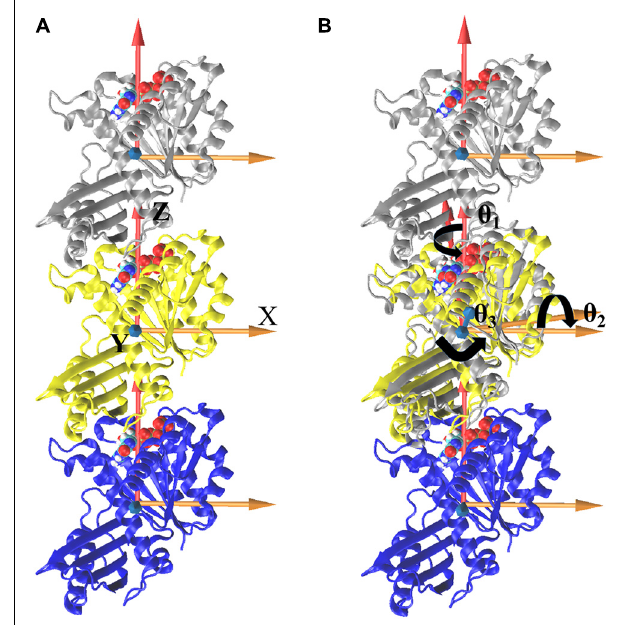
FIGURE 4 | Definitions of bending and twisting angles. Overall, the coordinate system was defined by aligning the z axis along the center of mass position of the one subunit to that of another subunit, fixing the x axis along a preferred bending direction for the trimer and defining an orthogonal y axis (A) . To measure the relative motions, trimer was first aligned with respect to the initial straight frame by superposing the middle subunits (yellow). The bending angles, θ 1 (rotations around the Z axis), θ 2 (rotations around the X axis), and θ 3 (rotations around the Y axis), were then tracked by calculating the rotations of the top (silver) subunit to align the initial reference frame of the middle subunit ( B , align top subunit as an example). The same procedure is performed for bottom subunit, and the right-handed coordinate system is used